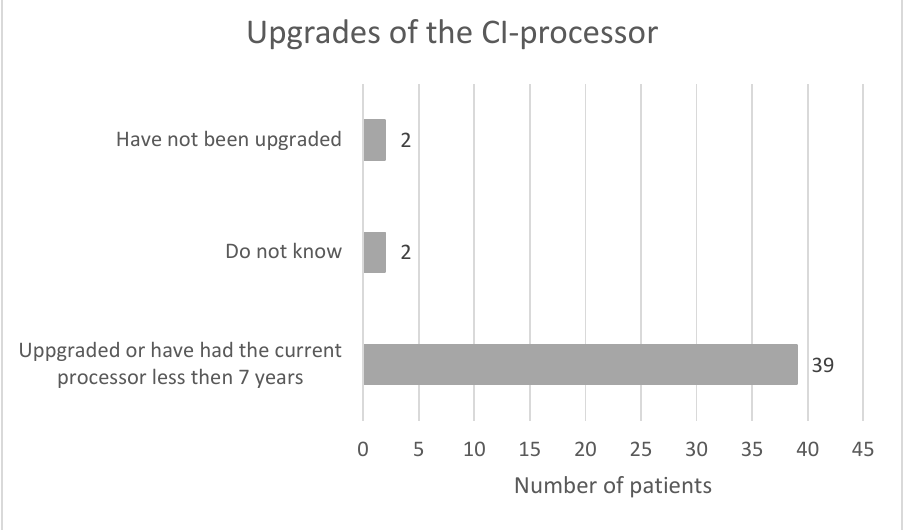
Figure 11. Upgrades of the CI-processor for patients in the study.